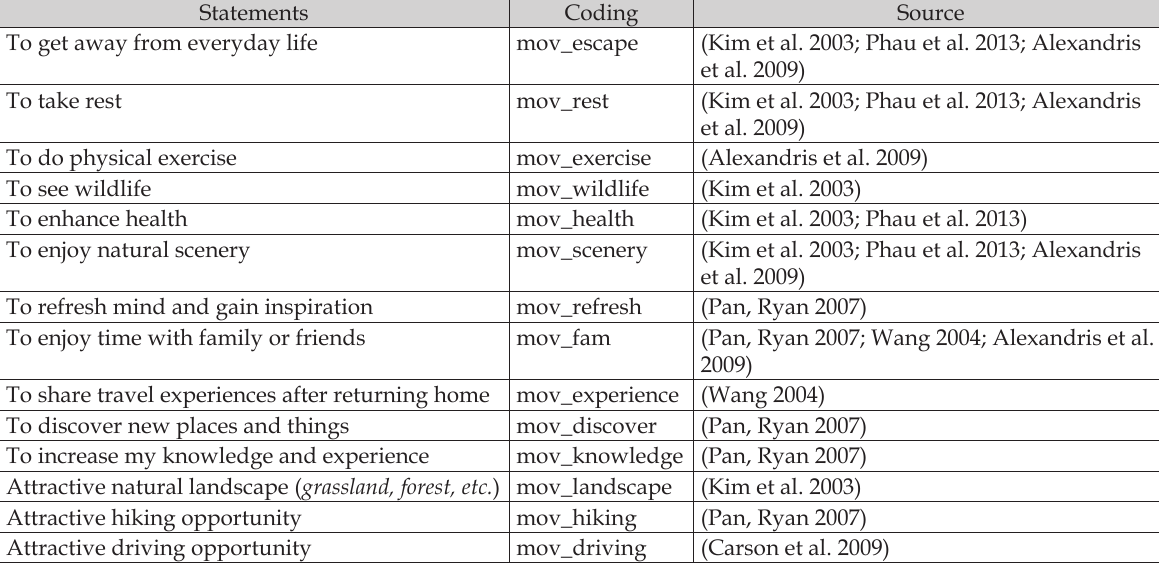
Table 1. Coding and literature sources of push- and pull-factor